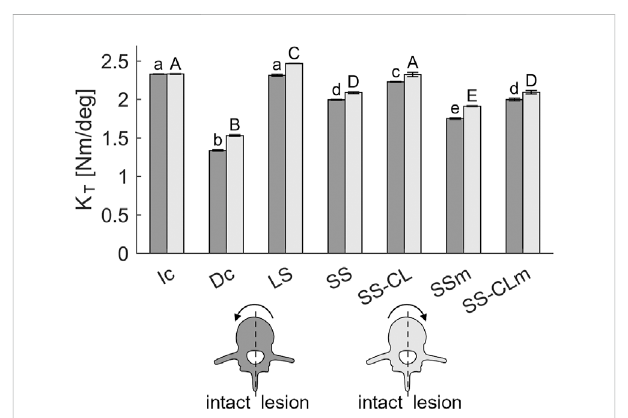
FIGURE 5 Torsional stiffness of each studied con fi gurations. The labels above the bars were obtained through a Bonferroni post-hoc test performed separately for torque on the intact (a – e labels) and lesion (A – Elabels)sides.Thesamelabelsindicatestatisticalsigni fi cance among the